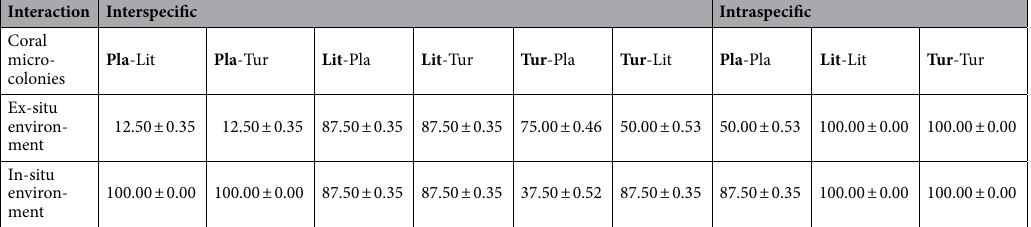
Table 2. The probability of survivorship (mean ± S.D. %; n = 8) of coral species under intraspecific and interspecific interactions in ex-situ and in-situ conditions. “Pla-Tur” denotes Platygyra sinensis micro-colonies were placed 1 cm apart from Turbinaria mesenterina micro-colonies. Pla = Platygyra sinensis , Tur = Turbinaria mesenterina , Lit = Lithophyllon undulatum. Bold indicates the coral species whose micro-colonies were examined for